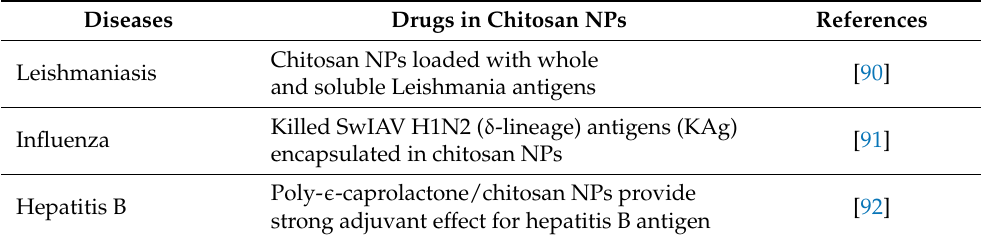
Table 6. Chitosan NPs in vaccine delivery.